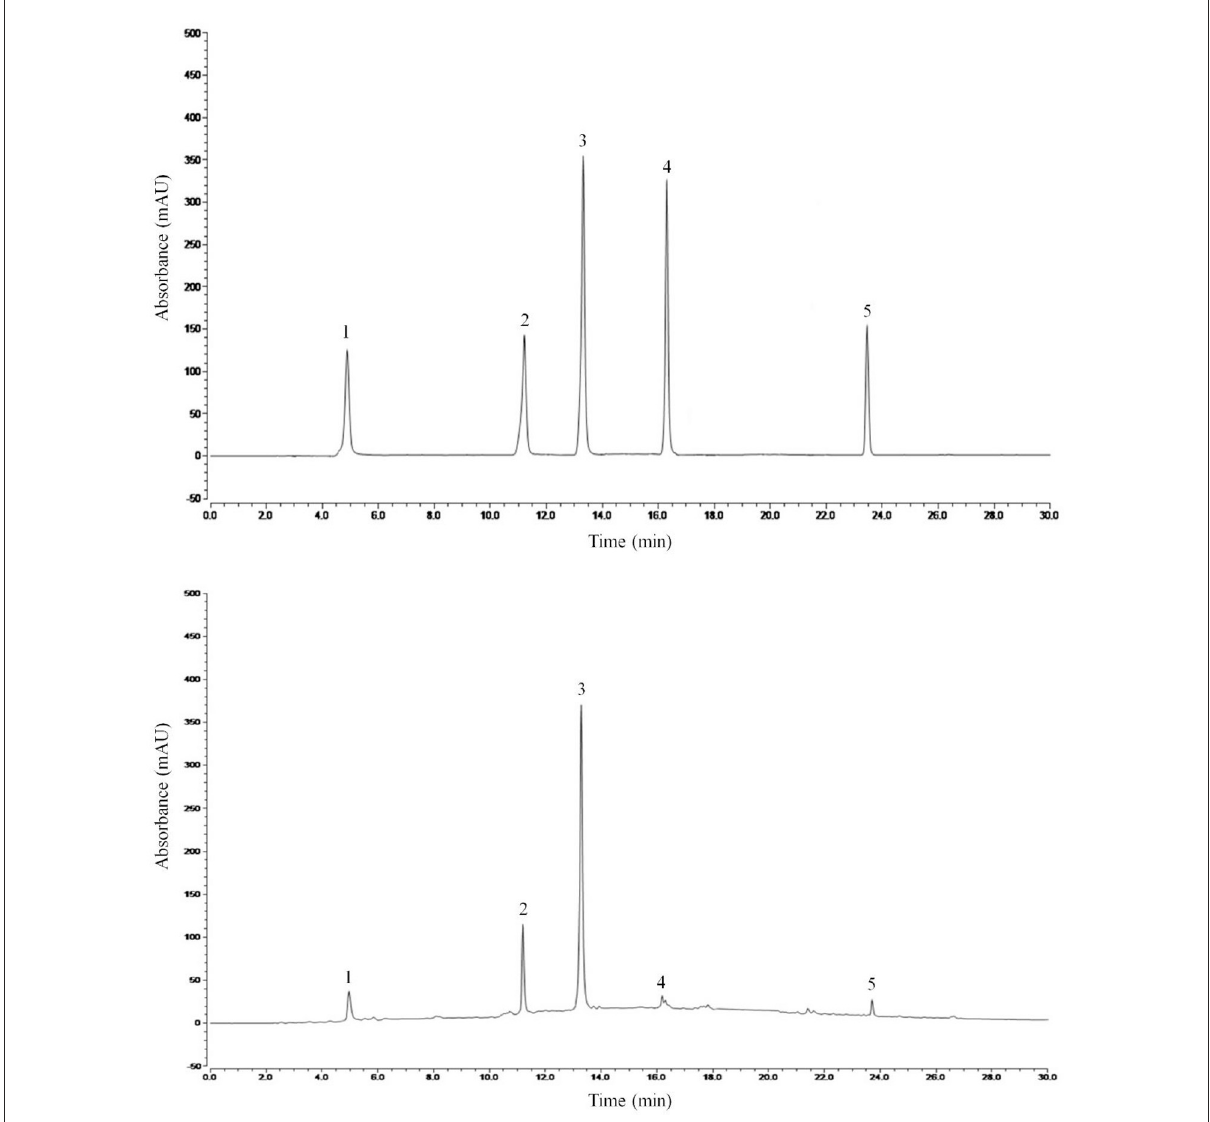
FIGURE7 HPLC standard and Malus doumeri leaf extract chromatogram: 1, chlorogenic acid; 2, isoquercitrin; 3, quercetin; 4, baicalin; 5,